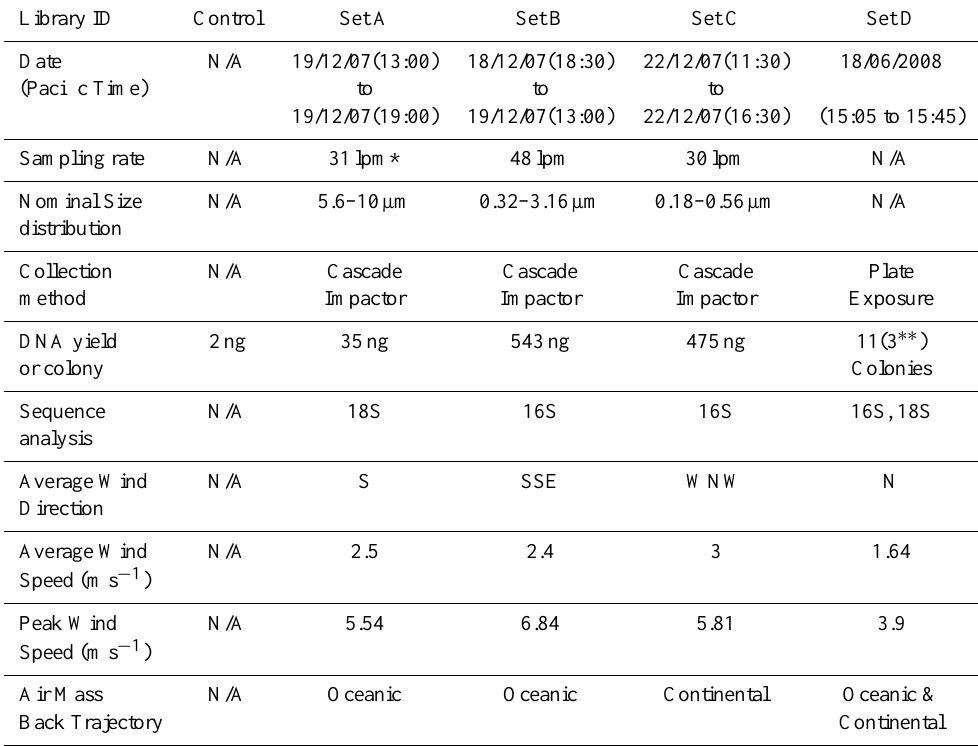
Table 1. Summary of Sampling Conditions at the SIO